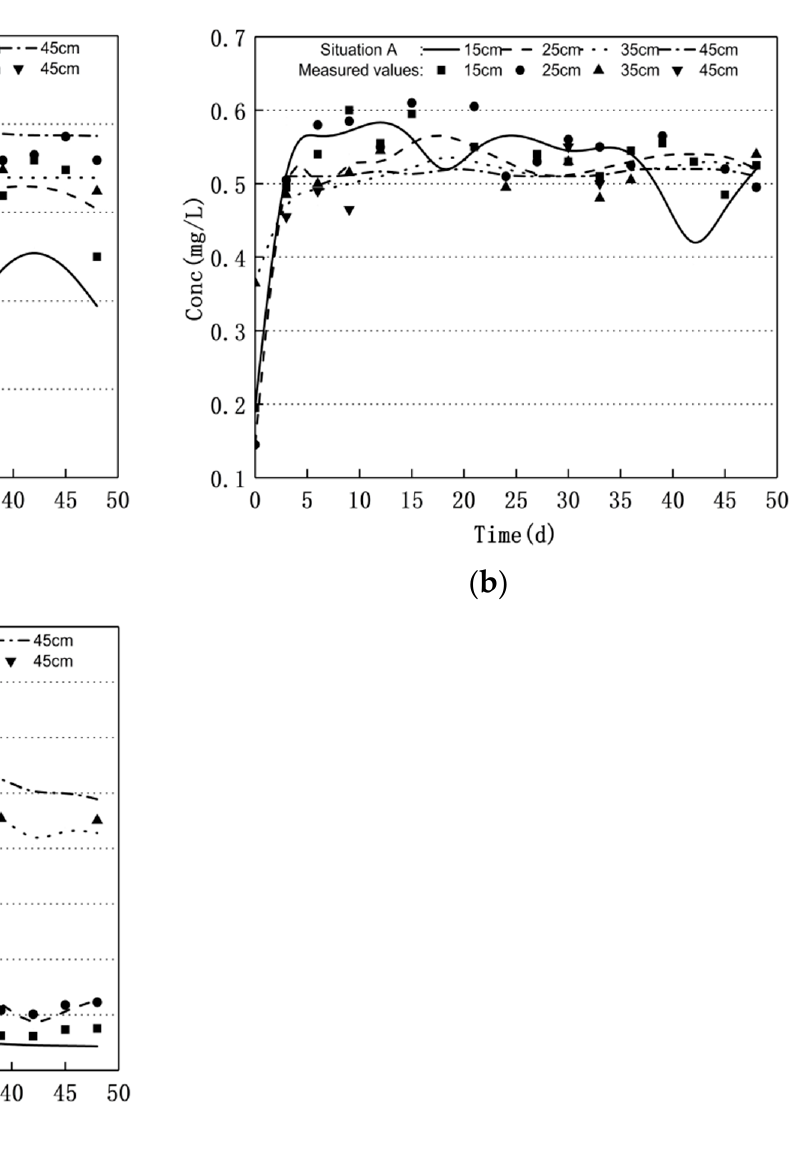
Figure 4. The process of nitrogen change in coarse sand (( a ) nitrate nitrogen; ( b ) nitrite nitrogen; ( c ) ammonium nitrogen).